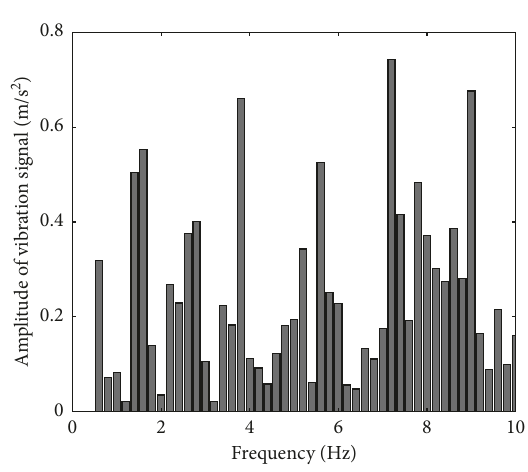
Figure 8: Difference (|brc